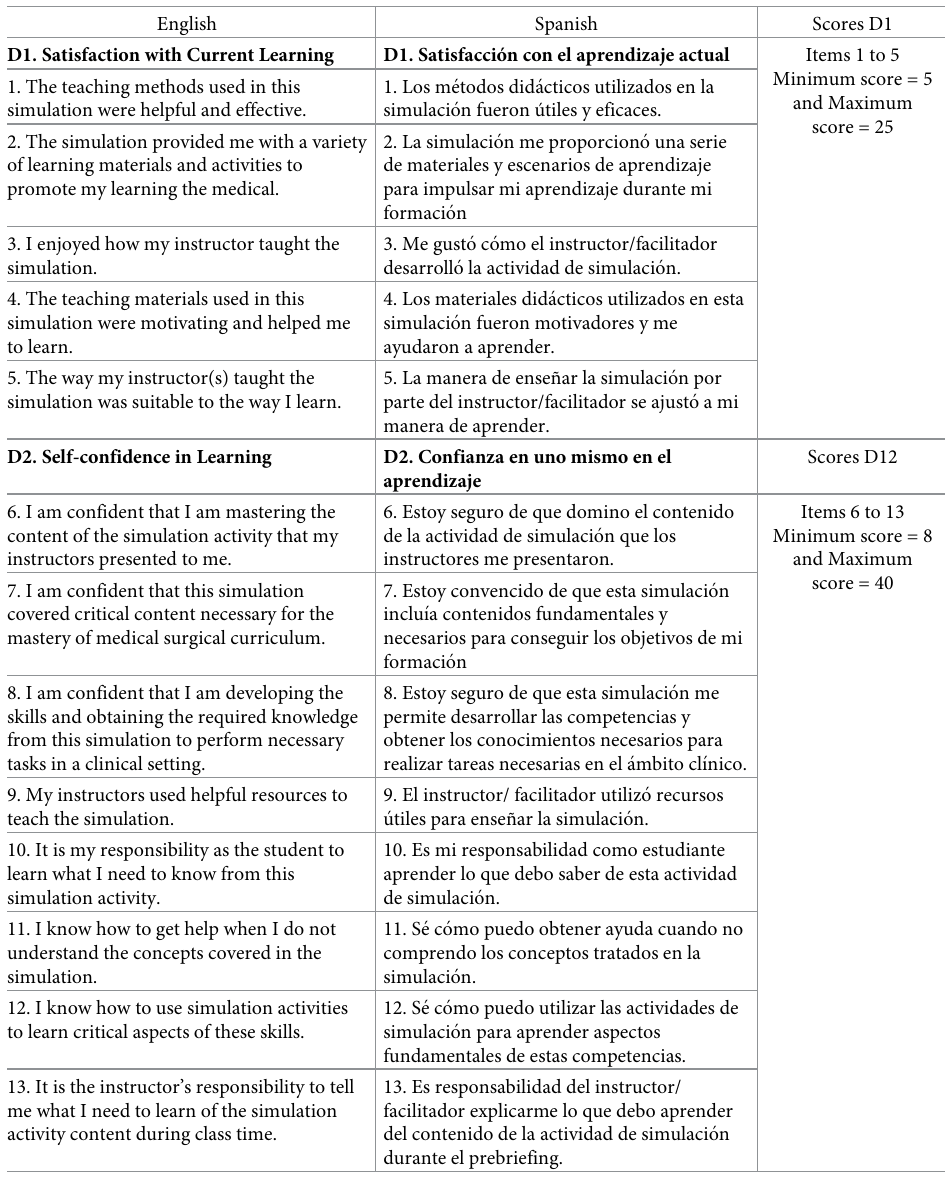
Table 1. Shows the semantic equivalence of items from English to Spanish that were metrically validated and dis- tribution of the items in each dimension and minimum and maximum scores of the original student satisfaction and self-confidence in learning